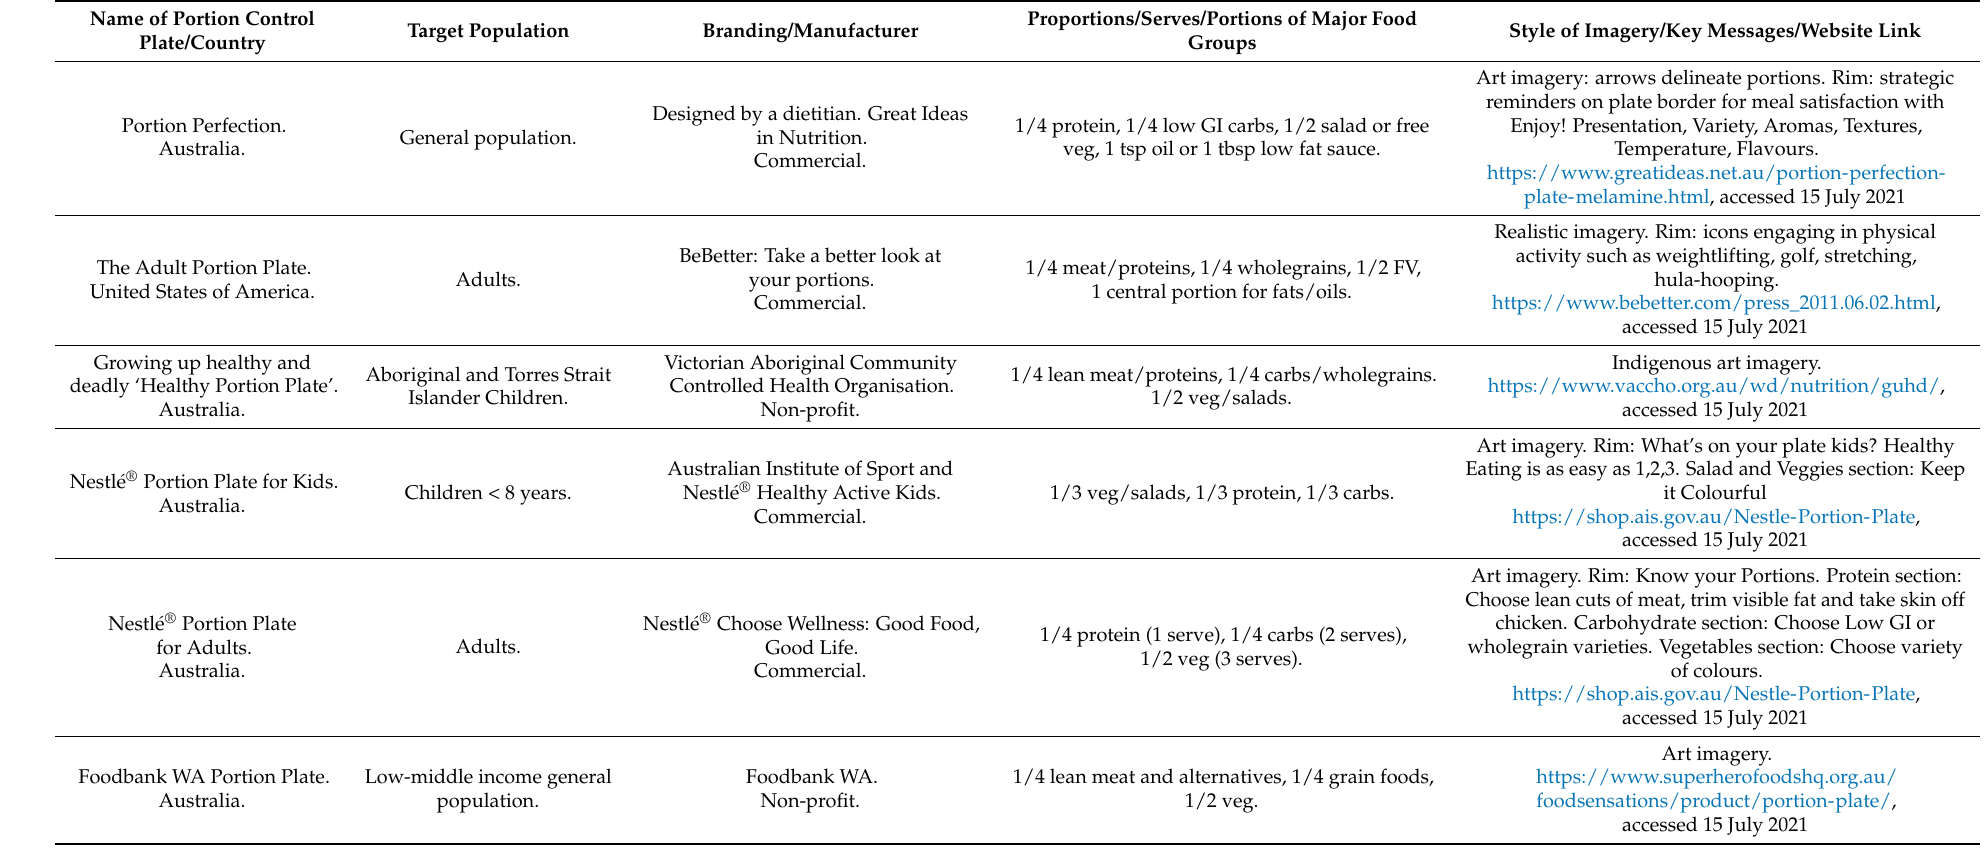
Table 4. Grey literature reporting characteristics of portion control